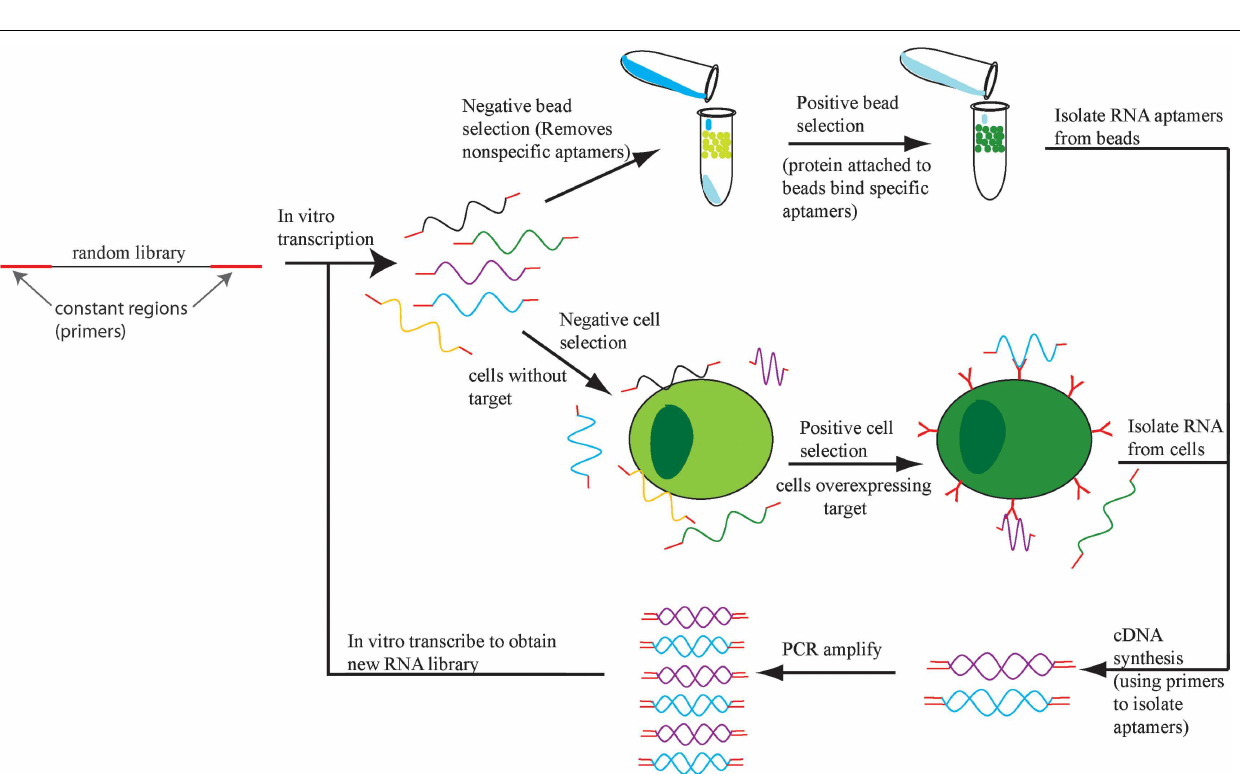
FIGURE 1 |The SELEX process. An initial DNA library is transcribed into RNA and the aptamers that bind to cells or beads with no target protein are eliminated. The remaining aptamers are applied to cells or beads with target protein and the bound aptamers are retrieved, amplified, and the SELEX process